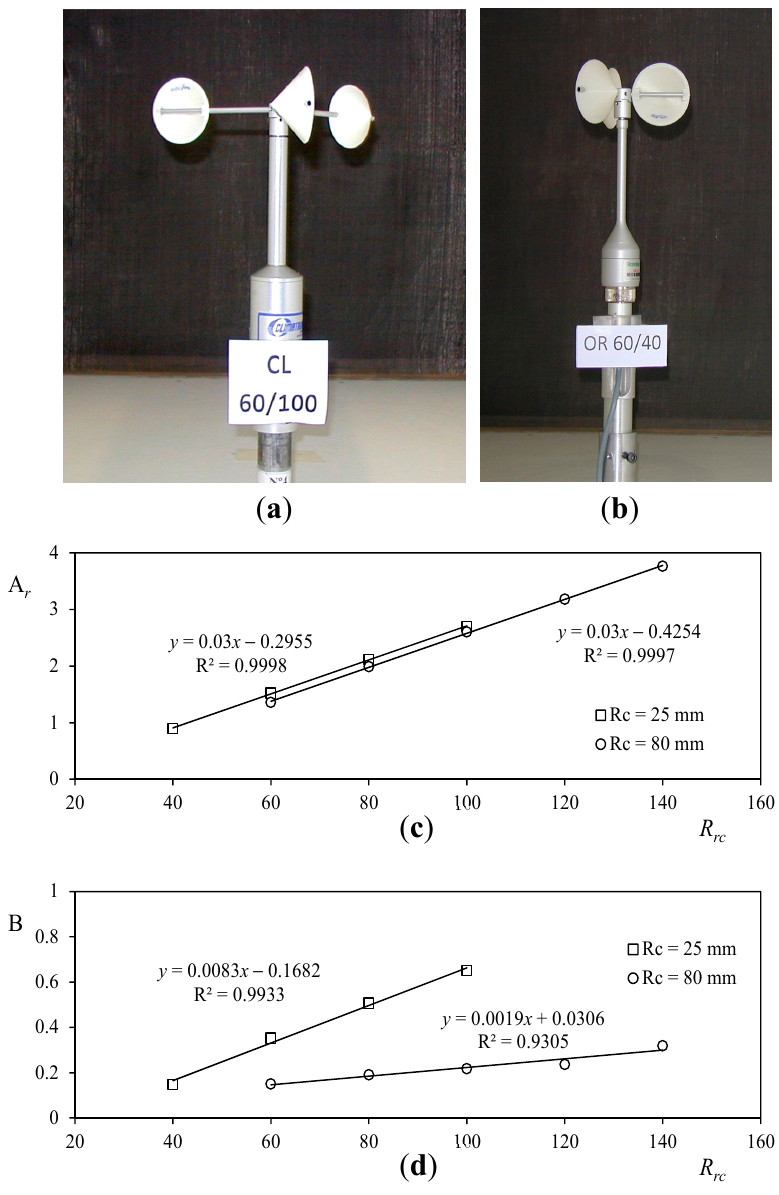
Figure 5. Climatronics 100075 with a R c = 30 mm and R rc = 100 mm rotor ( a ) and Ornytion 107A with a R c = 30 mm and R rc = 40 mm rotor ( b ) cup anemometers. A r ( c ) and B ( d ) calibration coefficients (see Equation (2)), in relation to the cups’ center rotation radius, R rc , for two different size conical cups ( R c = 25 mm and R c = 80 mm).